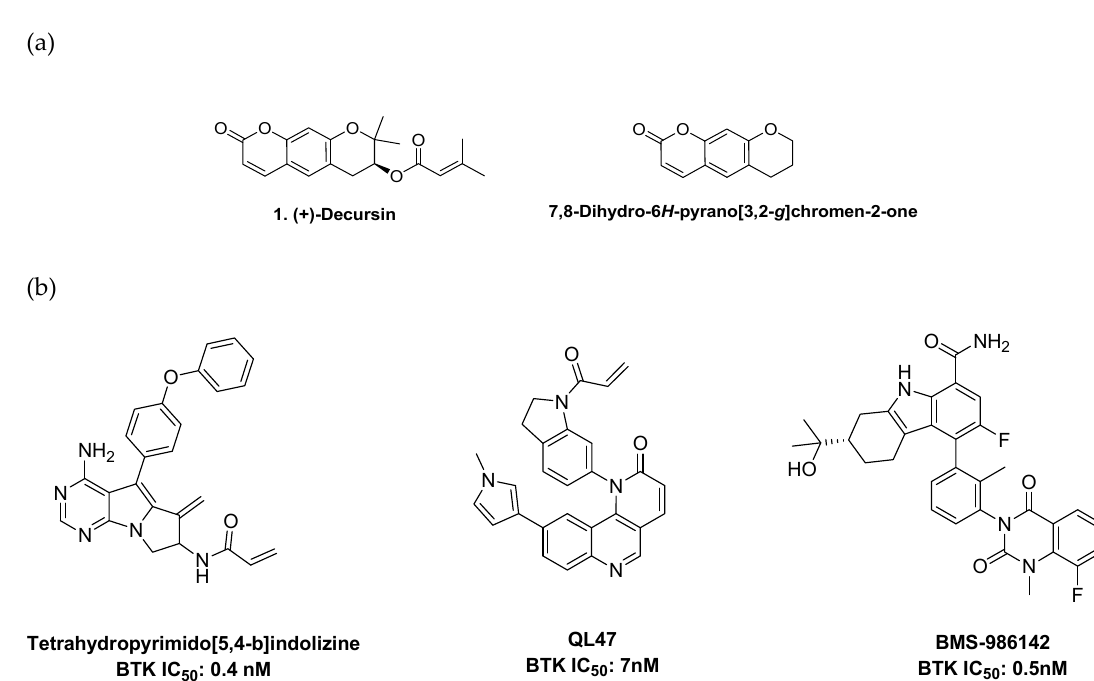
Figure 2. ( a ) Structures of decursin and pyranochromenone. ( b ) Reported tricyclic BTK inhibitors.